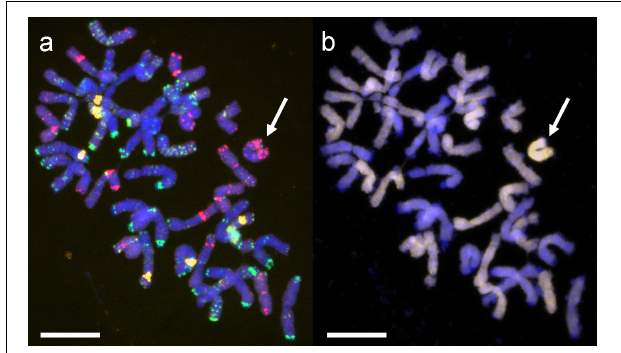
FIGURE 1 | Mitotic chromosomes of hybrid genotype 1 (BC 2 F 4 ) ( Ae . tauschii × S . cereale ) × Triticosecale cv. Bogo analyzed using (a) FISH with pTa-535 (red), pTa-86 (green) and pTa-k374 (28S rDNA) (yellow) probes, (b) GISH with total genomic DNA probe of Ae . tauschii (D, yellow) and triticale (ABR, blocking DNA). Arrows indicate the introgressed chromosome 2D. Scale bars 10 µ m.